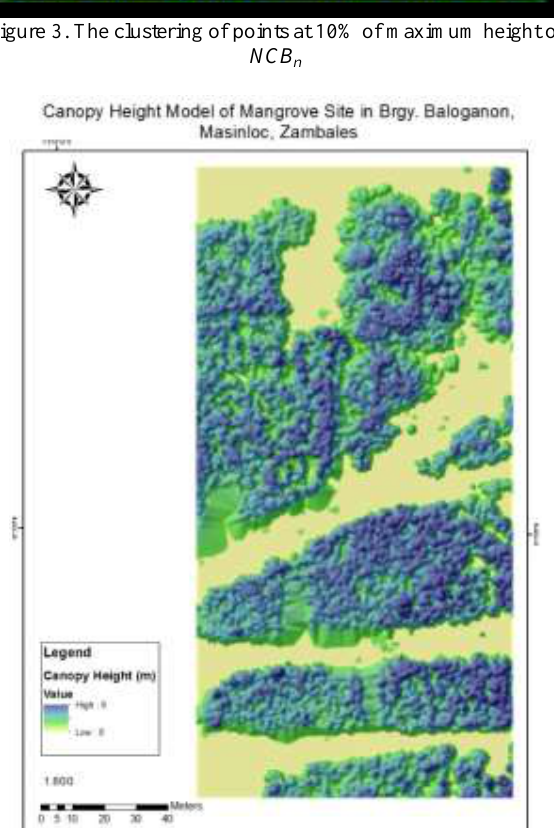
Table 3. Measure of central tendency of the point density clustering per sample